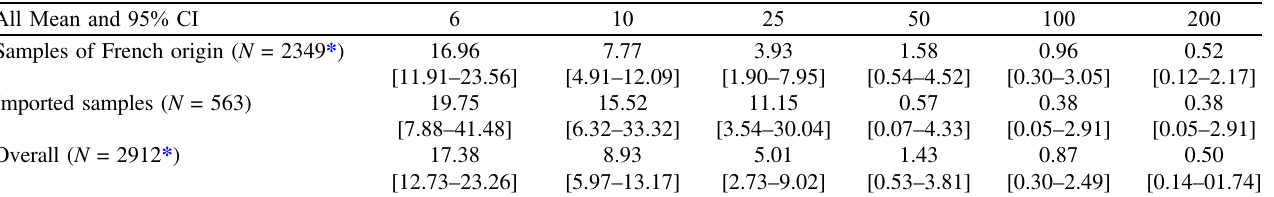
Table 2. The overall seroprevalence of Toxoplasma gondii infection in beef consumed in France accordingly to the terminal titer (6; 10; 25; 50; 100; 200). Only one positive sample at terminal titer of 400 (adult of French